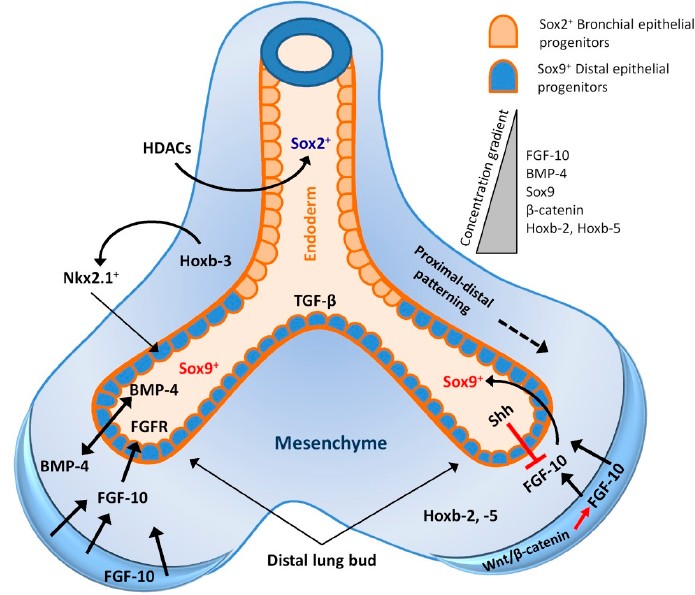
Figure 1. Epithelial-mesenchymal cross-talk and governing signalling during early development and branching morphogenesis of lung. Factors are represented only at sites where the expression is most abundant. Fibroblast growth factor-10 (FGF-10) is highly expressed in the distal mesenchyme and acts as a chemotactic focus for the epithelium during lung budding. FGF-10 also regulates Sox9 expression in the distal epithelial progenitors and induces bone morphogenetic protein (BMP)-4 expression. Sox2 expression in the proximal epithelium is under regulation of histone deacetylases 1/2 (HDAC1/2) signalling. FGF-10 expression in the mesenchyme is regulated by Wnt/ β -catenin signalling (red arrow). A high concentration of BMP-4 signal also serves to locally inhibit endoderm proliferation, thereby inducing the lateral outgrowth of new airway branches. Sonic hedgehog (Shh) at the distal tips functions to downregulate FGF-10 expression in the mesenchyme, which limits local budding. Transforming growth factor- β (TGF- β ) signalling also prevents local budding, by decreasing endodermal proliferation and by stimulating synthesis of matrix components at branch points. Solid arrows indicate sources from and influences on cells/molecules; dotted arrow indicates direction of patterning.